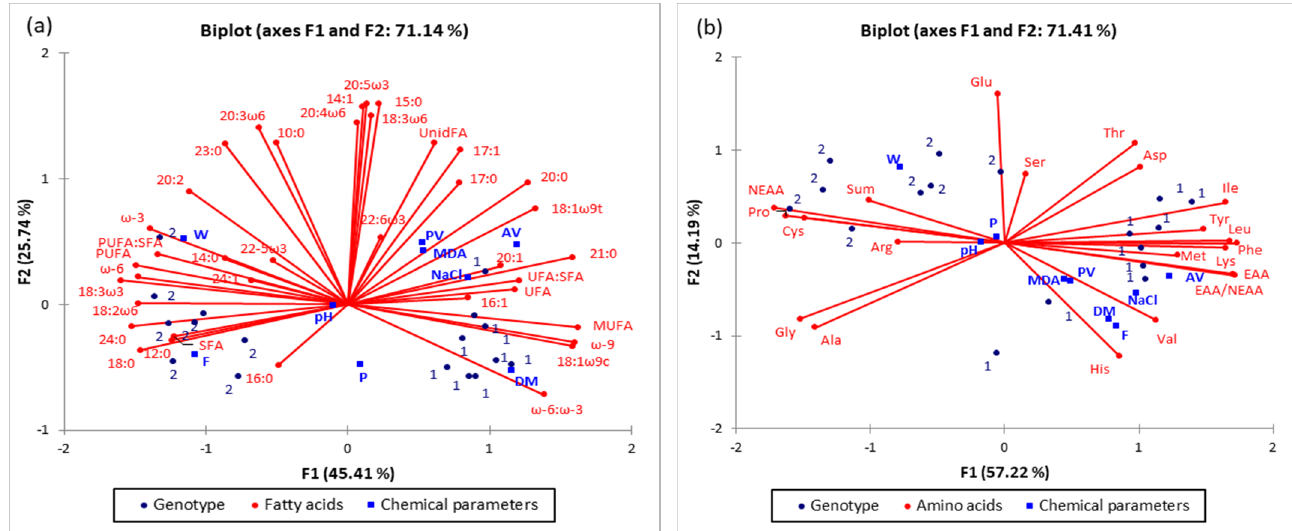
Figure 2. Score plot of the first two principal components (PC1 and PC2), of the principal component analysis, showing variance based on the ( a ) fatty acid composition and ( b ) amino acid composition of matured Istarski pršut of two different genotypes, LWxL (1) & (LWxL)xD (2).